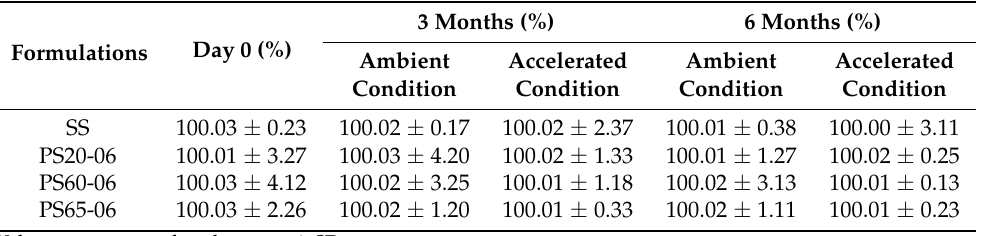
Figure 8. Illustrates the percentage of cellular uptake of NDP powder, SS, and PS20-06 after exposure with each formulation for 6 h (n = 3). Table 4. Percentages of NDP dissolved after storage under ambient (25 ◦ C) and accelerated (40 ◦ C/75% relative humidity)